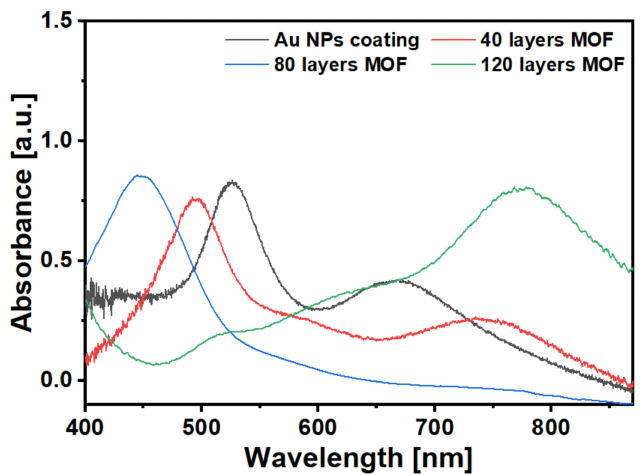
Figure 6. The absorption spectra of an OFS coated with Au NPs only (black trace) and Au NPs plus MOF film coated with 40 cycles (red trace), 80 cycles (blue trace) and 120 cycles (green trace). The absorbance value of the OFS is calculated by referencing the spectrum of the bare fibre.